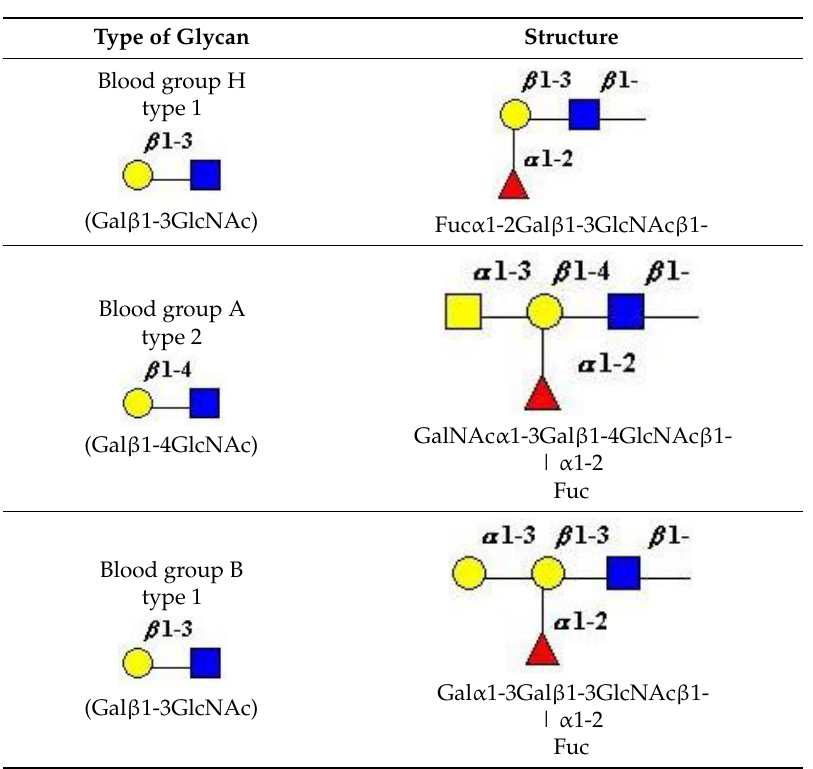
Table 5. Key Glycan Structures found in Mucins.